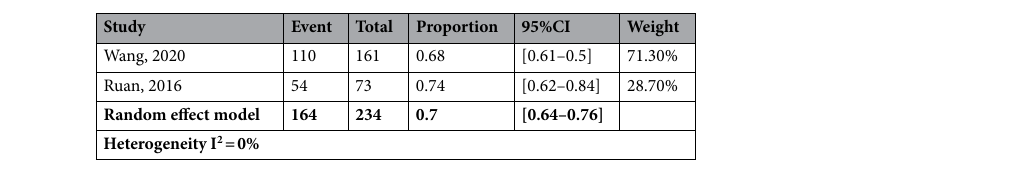
Table 10. Catastrophic Health Expenditure (Capacity to Pay at